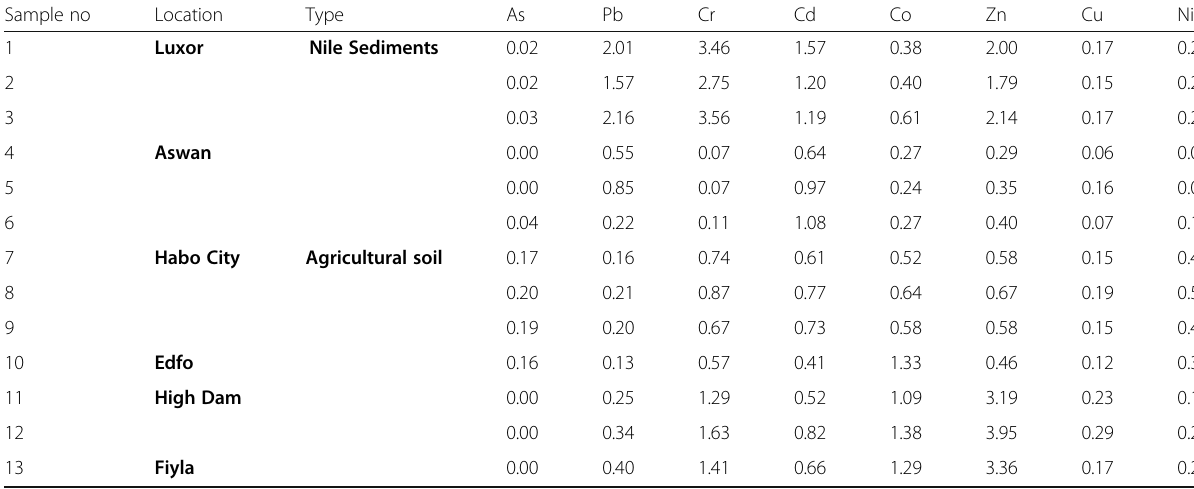
Table 4 Enrichment factor of the sediments of the study samples Sample